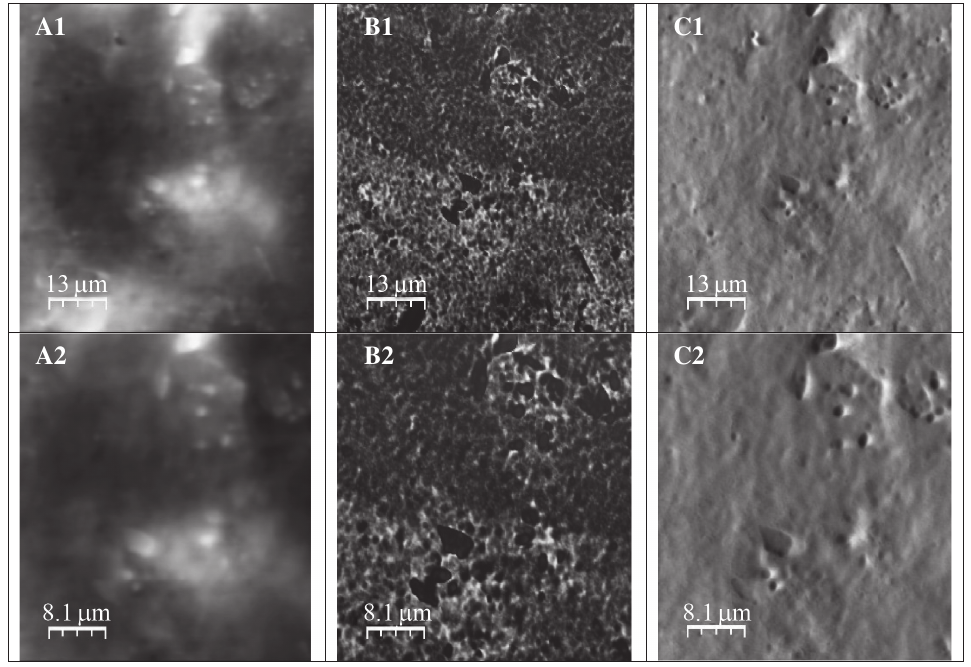
Figure 1: AFM photo- graphs of EPDM_40 sur- face micromorphology, taken in two different magnifications (1, 2) from topography channel (A), amplitude channel (B) and phase channel